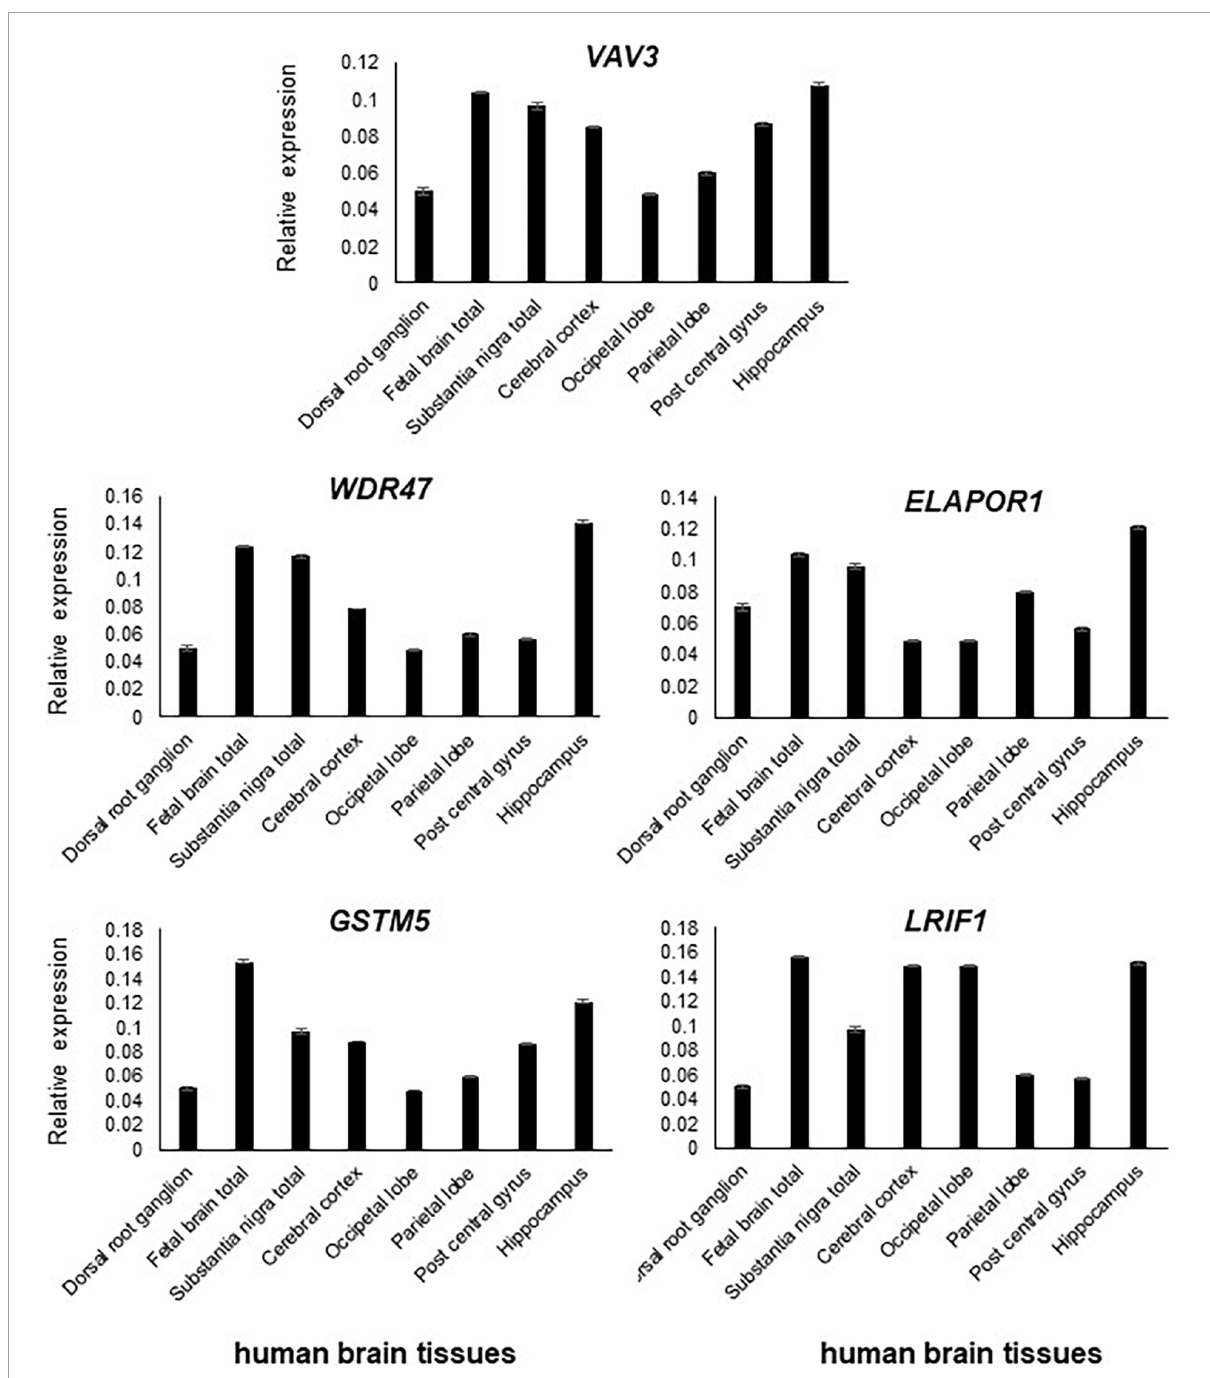
FIGURE3 All five genes, namely, VAV3, WDR47, ELAPOR1, GSTM5, and LRIF1, are expressed in the various parts of the brain with varying levels.